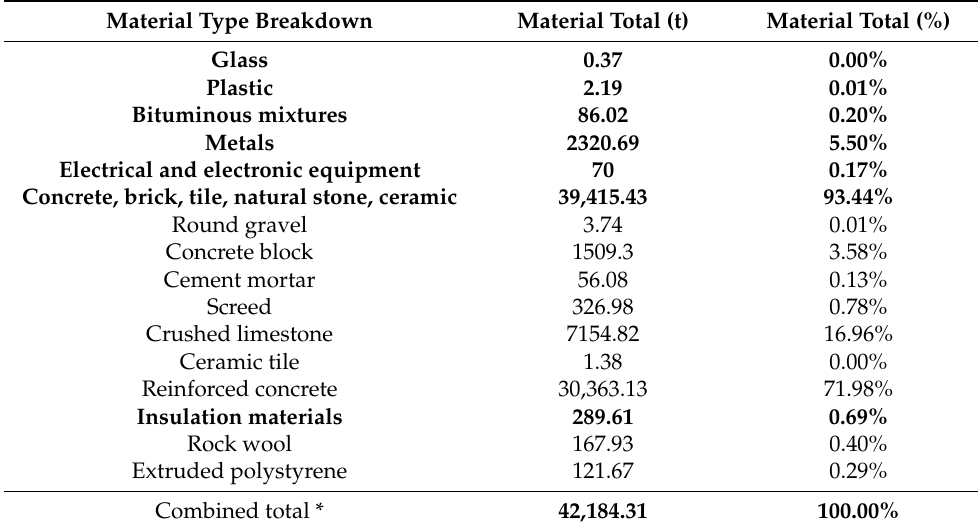
Table 3. Bill of materials output regarding shell building elements by material type in terms of total weight and percentage of